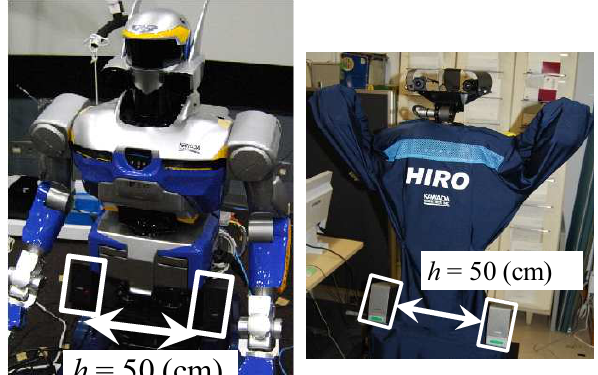
Figure 11. HIRO with its stereo loud- speakers